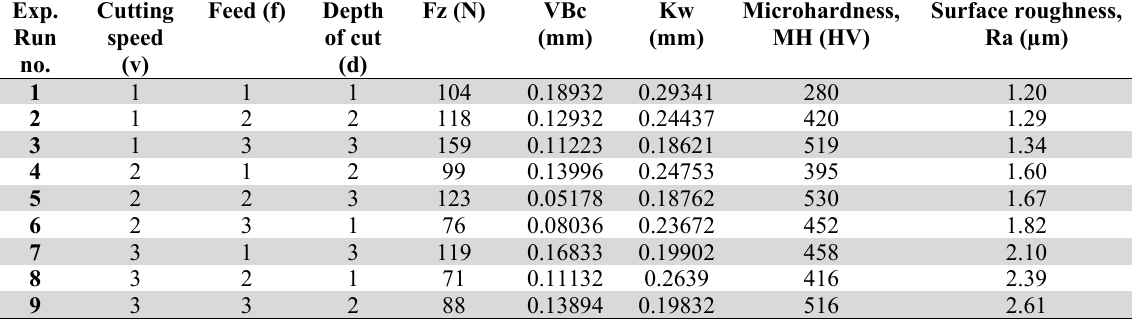
Experimental details of EN 24 machining using coated cermet under dry machining environment (A. Das et al., 2019) Exp.